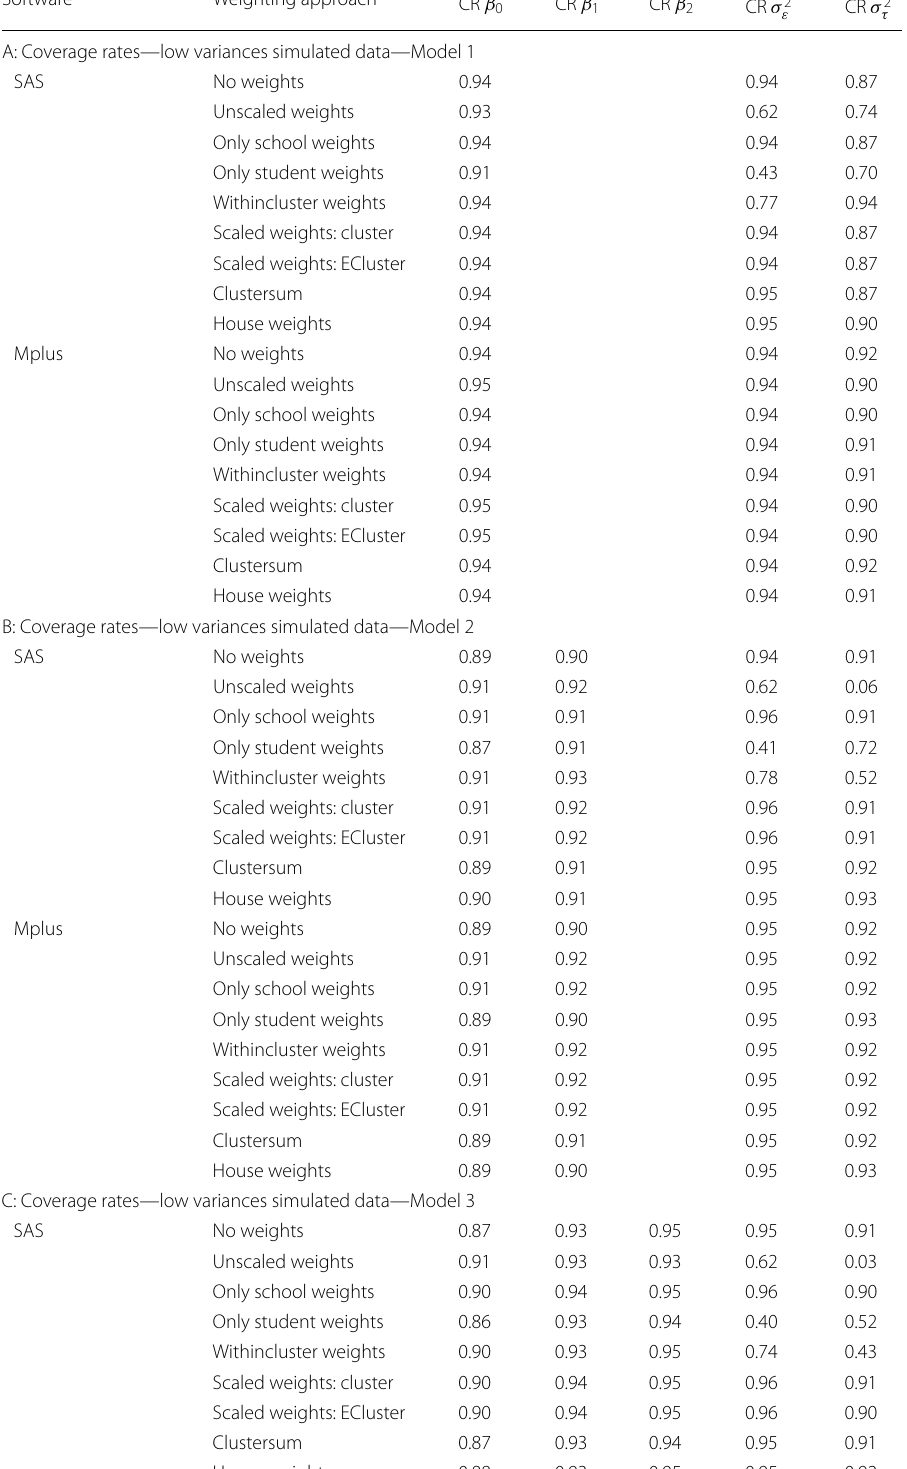
Table 6 Coverage rates of low variances simulated data